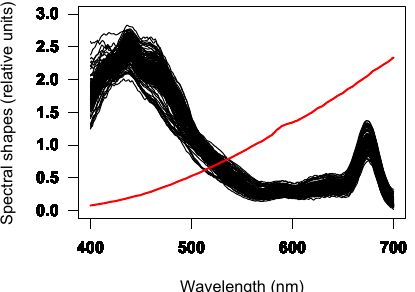
Figure 2. Spectral shapes of the tungsten-halogen lamp used in the incubations conducted by the Bedford Institute from 1984 to 2003 (red line) and in vivo absorption spectra of marine phytoplankton collected in the North Atlantic and subpolar waters (Labrador Sea). Phytoplankton and lamp spectra were normalised to their mean value to define the